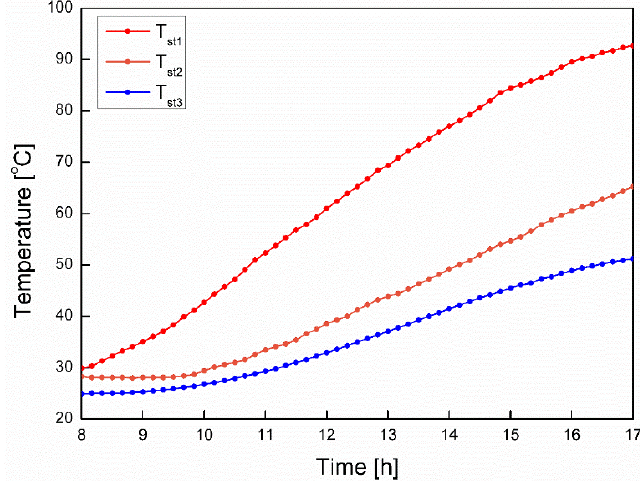
Figure 6. Temperature variation in each storage tank zone.